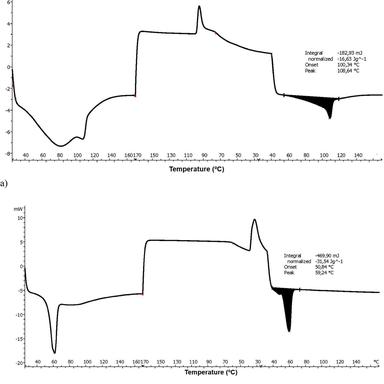
DSC profile of the RO paper a), SP paper b), IT paper c) and SLO paper d).